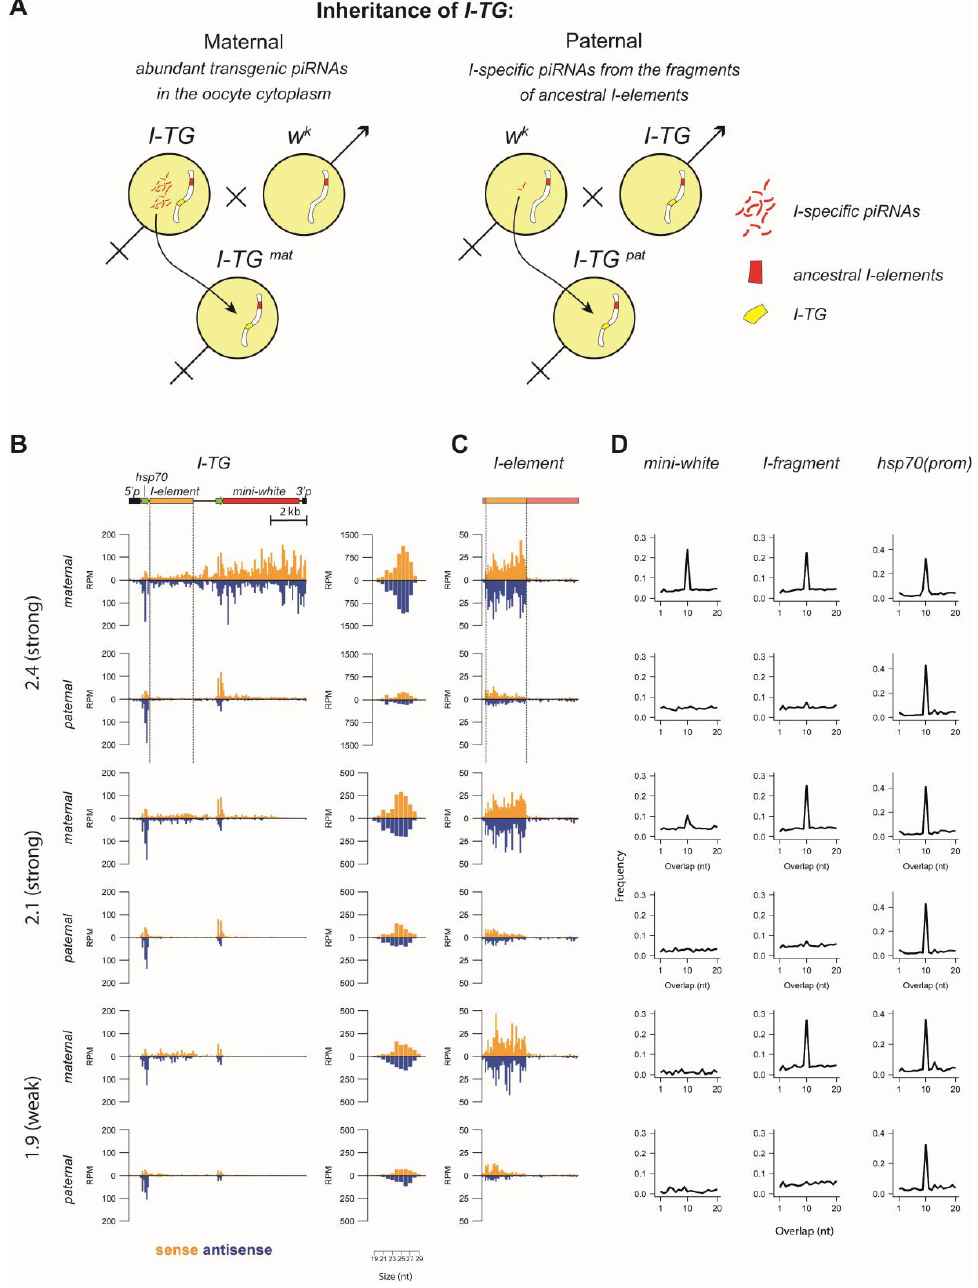
Figure 4. Small RNA production and chromatin structure of maternally- and paternally-inherited I-TG transgenes. ( A ) The scheme of the experimental design is shown. ( B ) Normalized numbers (RPM) of ovarian small RNAs (19–29 nt) mapped to the indicated transgenic constructs inherited maternally or paternally (brown—sense; blue—antisense; no mismatches allowed). The scheme of the I-TG transgene is shown above. The length distribution of transgenic small RNAs is shown to the right. ( C ) Small RNA distribution along the canonical I -element in the R strains after maternal / paternal transgene inheritance. ( D ) Ping-pong signature: the relative frequencies of 5 (cid:48) -overlap length (one to 20 nucleotides) between sense and antisense 24–29-nt piRNAs for the transgenic I -fragment, the mini-white region, and the hsp70 promoter are